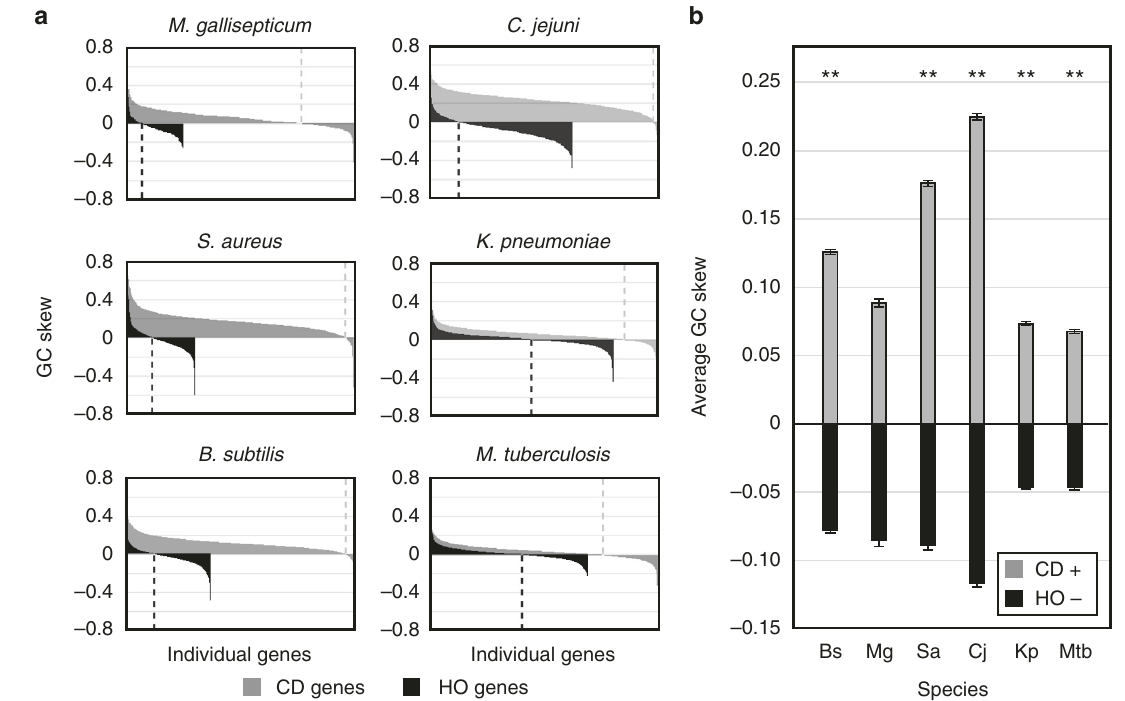
Fig. 5 New head-on alleles are retained after inversion. a The distribution of GC skew values for all co-directional (leading strand, gray) or head-on (lagging strand, black) genes are plotted, one column per gene. Columns are sorted from the highest to lowest GC value resulting in the appearance of a curve. Values below zero represent inverted genes, whereas values above zero suggest long-term orientation conservation. Dashed lines highlight the in fl ection point between positive and negative value in each group. b The magnitude of the average GC skew of inverted head-on genes (those with a negative GC skew, black) is diminished relative to retained co-directional genes (those with a positive GC skew, gray). Error bars represent the standard error of the mean. Statistical signi fi cance of the difference in magnitude between the two groups (CD + vs. HO − ) was determined per species using Z -test. ** p <